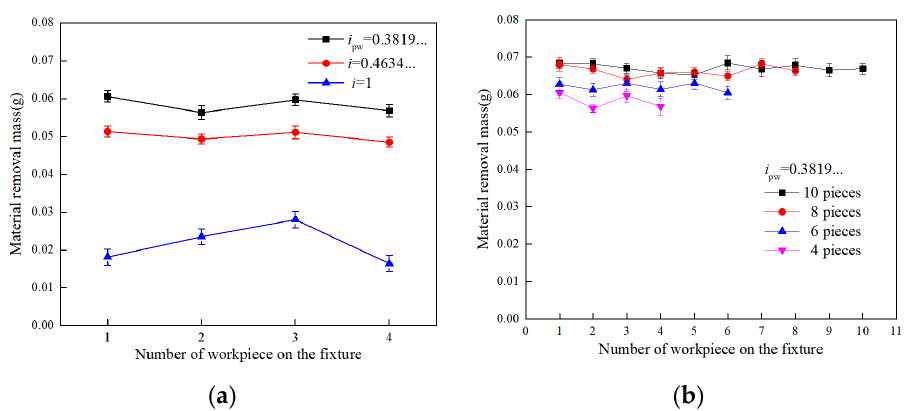
Figure 15. Effect of rotation speed ratios on: ( a ) material removal mass for each piece by considering 4 pieces of workpiece, and ( b ) material removal mass for each piece by considering 4, 6, 8 and 10 pieces of workpiece, respectively.